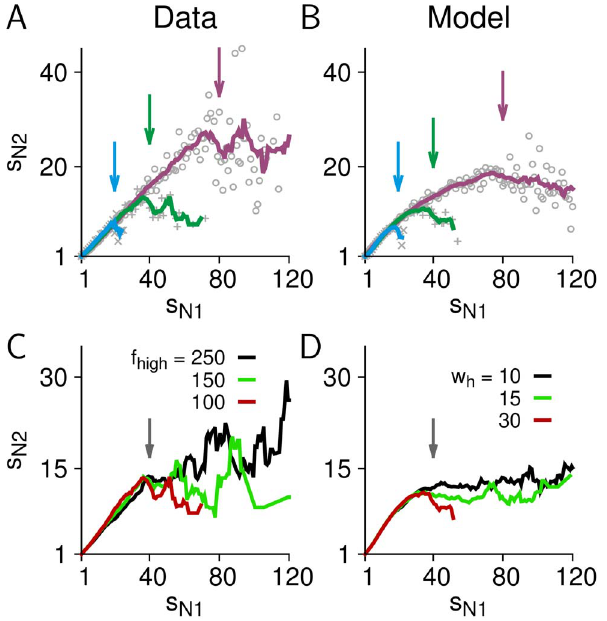
Figure 6. Size relationship of avalanches is only preserved for avalanches smaller than the observation window size. ( A ) Observing an avalanche of size s N1 # N 1 predicts the size s N2 of the corresponding avalanche observed in window N 2 , N 1 . This prediction power is lost for s N1 . N 1 . The sizes of nLFP clusters were measured for a window of size N 1 and plotted against the corresponding cluster sizes that were obtained for a window half as large, i.e., N 2 =0.5 6 N 1 (monkey 1). Vertical arrows indicate the sizes of the larger window. Shown are averages for each size s N 1 (gray symbols) and smoothed lines for better visualization ( 6 : N 1 =20, + : N 1 =40, o: N 1 =80). The smaller window with N 2 electrodes was completely contained within the larger window with N 1 electrodes. ( B ) The same as A for the model. ( C ) The same analysis for various values of the upper cut-off frequency, f high ( N 1 =40, N 2 =20; monkey 1). ( D ) The same as C for the model with various settings for temporal smoothing of the raw LSA